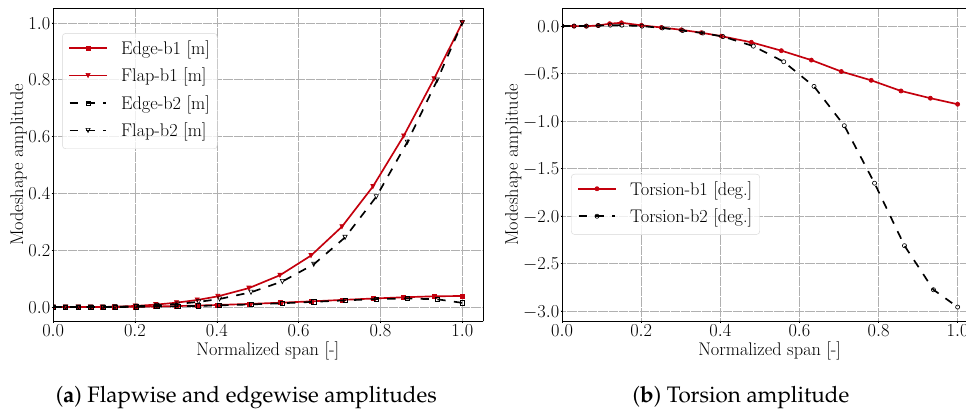
Figure 7. First mode shape flapwise and edgewise shown in ( a ), and torsion amplitudes shown in ( b ) for both blade designs (Blade-1: b1, Blade-2: b2) (structural response only). The prebend causes coupling between edgewise and torsion motions which can be seen in the second mode shape of the blades where the edgewise motion is the